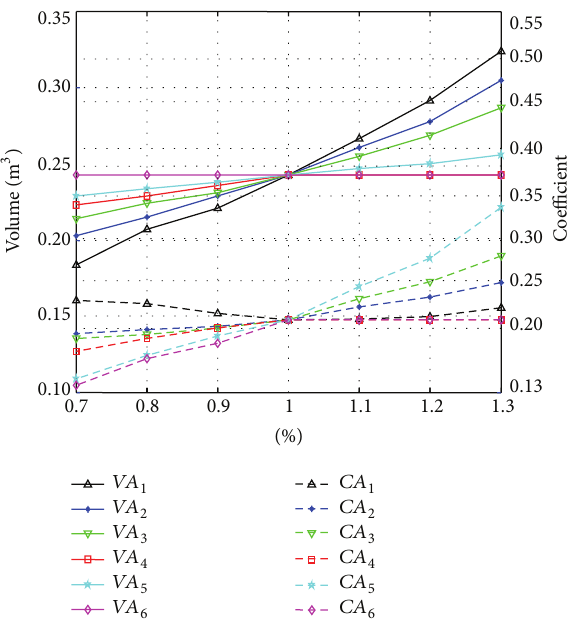
Figure 14: Relationship about link lengths, attainable space, and Manipulator Omnidirectional Coefficient. Figure 15: Relationship about joints angles, attainable space, and Manipulator Omnidirectional Coefficient.